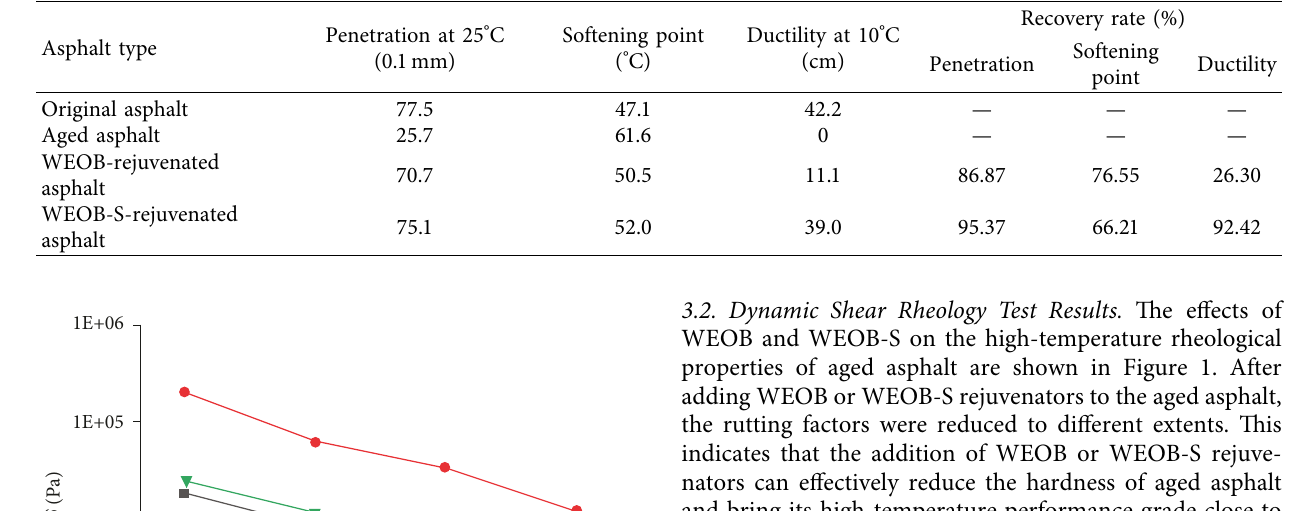
Table 3: Three major indicators and recovery rate of asphalt.